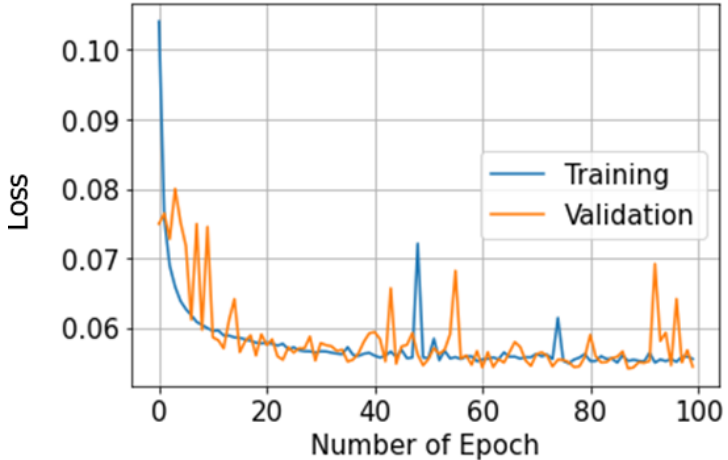
Figure 5. The graph illustrates the training and validation loss of the proposed model over a period of 100 epochs.